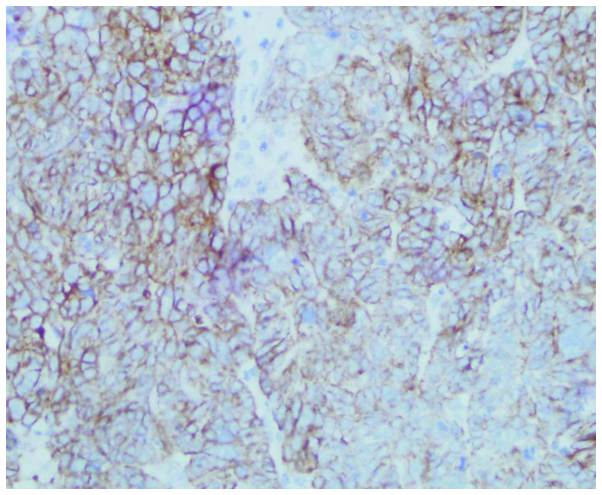
Immunohistological analysis of E-cadherin protein in ovarian cancer tissue (magnification, ×100).